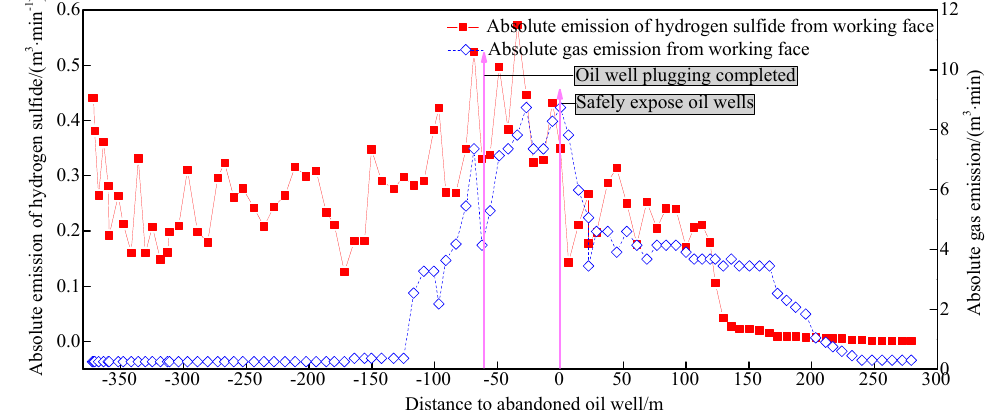
Figure 15. The trend diagram of absolute gas and hydrogen sulfide emission changes in the I0104 1 05 working face passing through the Ma tan 31 abandoned oil well.